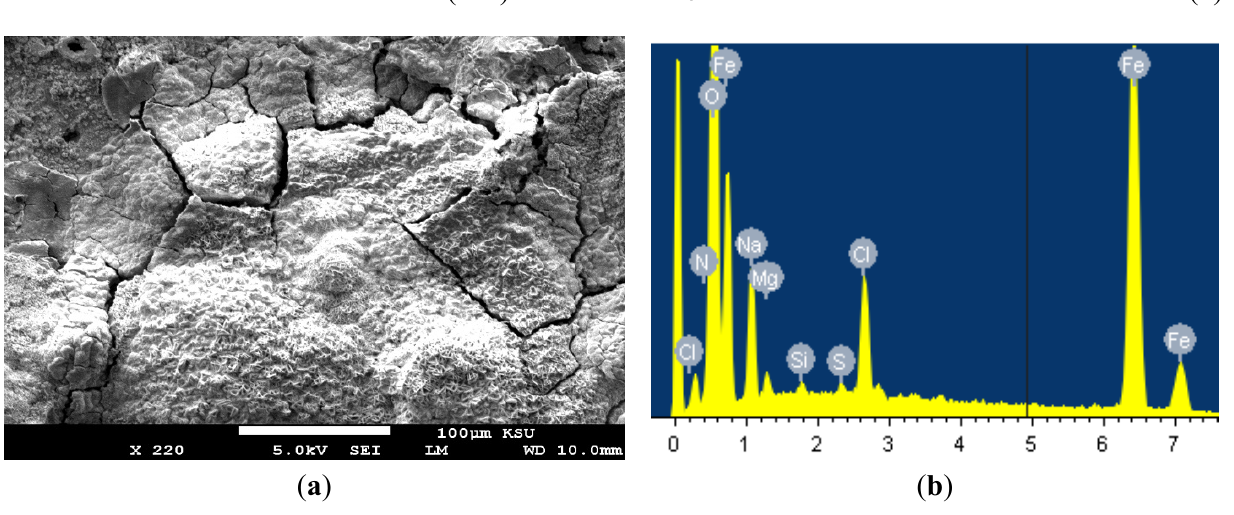
Figure 2. ( a ) SEM micrograph obtained for the cast iron coupons after its immersion in AGS for 10 days; and ( b ) the EDX profile analysis obtained for the surface shown in the SEM